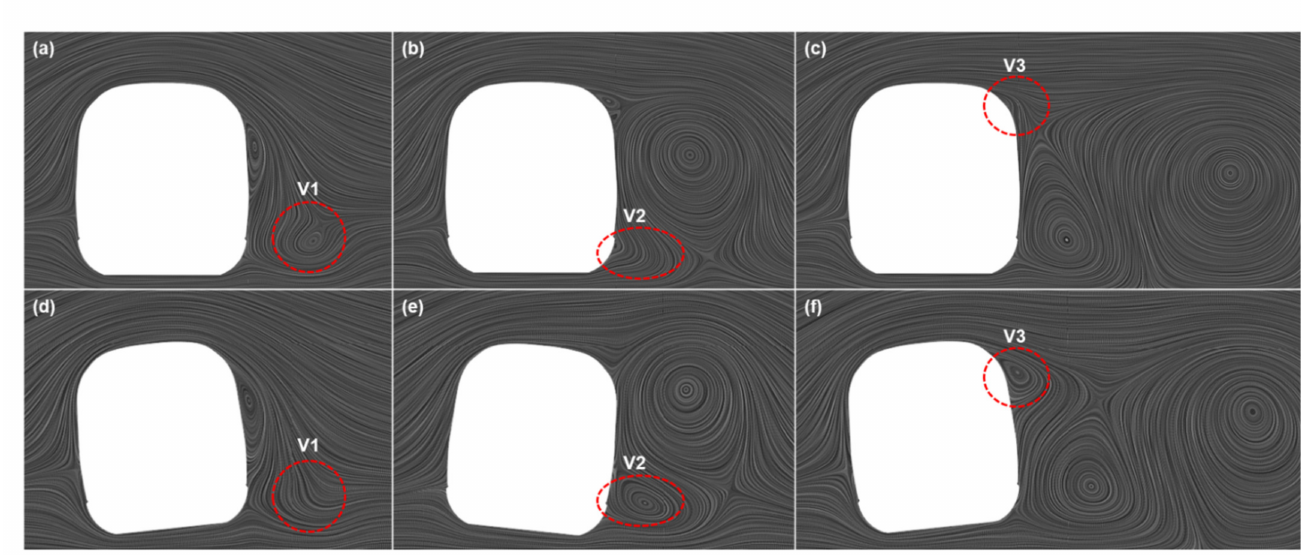
Figure 10. Velocity vector fields in the form of line integral convolution projected on the y–z plane at the middle length of: ( a ) the leading car of the original train; ( b ) the middle car of the original train; ( c ) the trailing car of the original train; ( d ) the leading car of the train with posture; ( e ) the middle car of the train with posture; ( f ) the trailing car of the train with posture.